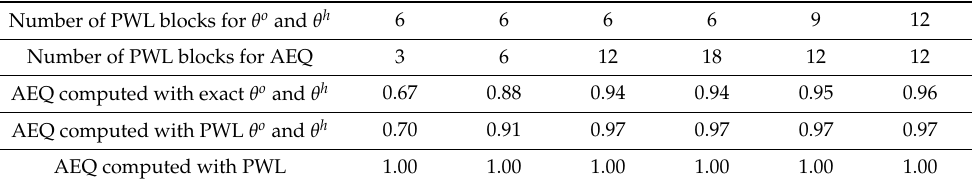
Table 4. Aging EQuivalent (AEQ) computation for different numbers of PWL segments.